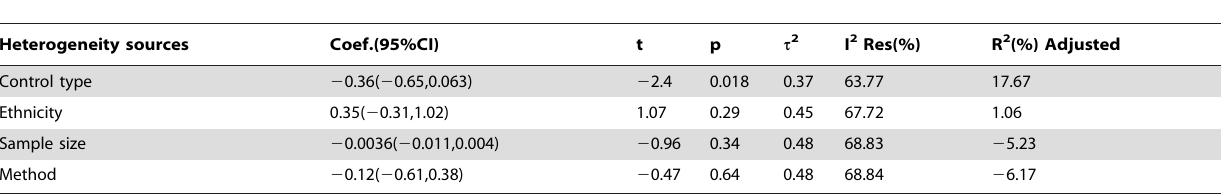
Table 2. Meta-regression analysis.